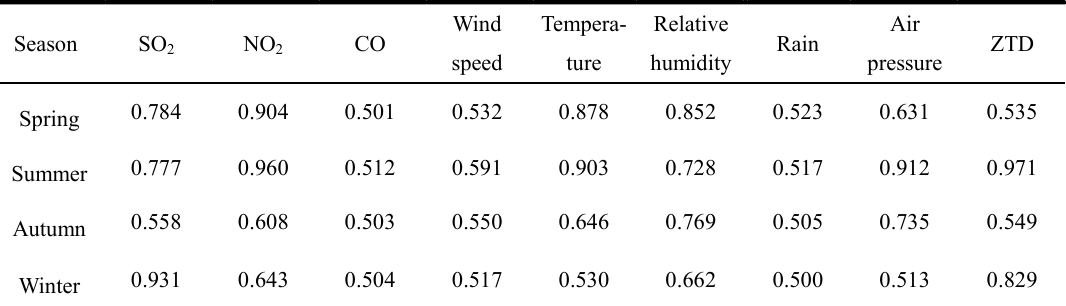
and meteorological factors and tropospheric 2.5